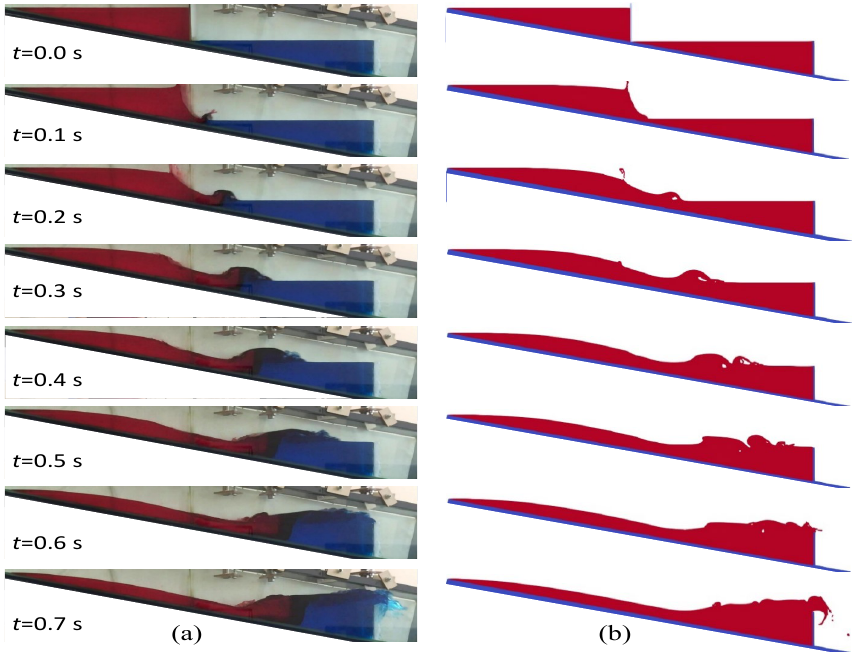
Figure 11. The visual comparison of the dam-break wave development ( a ) experiment ( b ) Smoothed Particle Hydrodynamics (SPH).